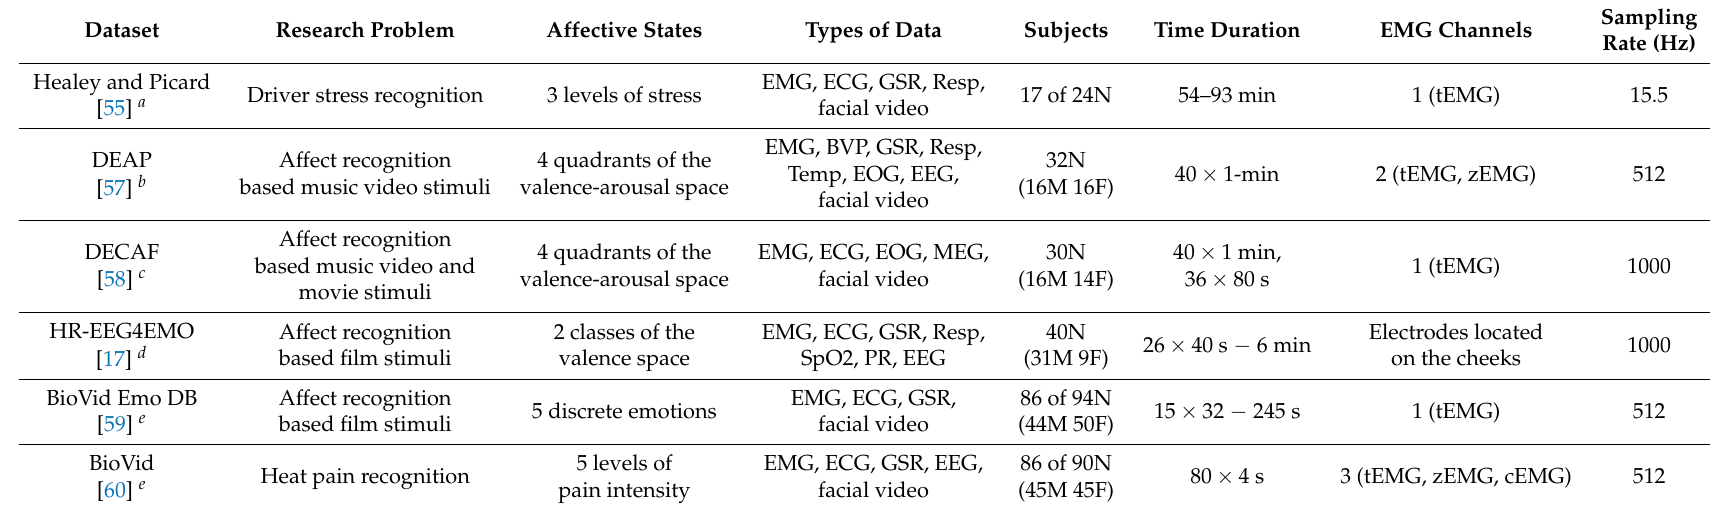
Table 4. Multi-modal physiological datasets for emotion recognition: subject, experimental protocol, acquisition setup, and pre-processing pipeline for measuring surface